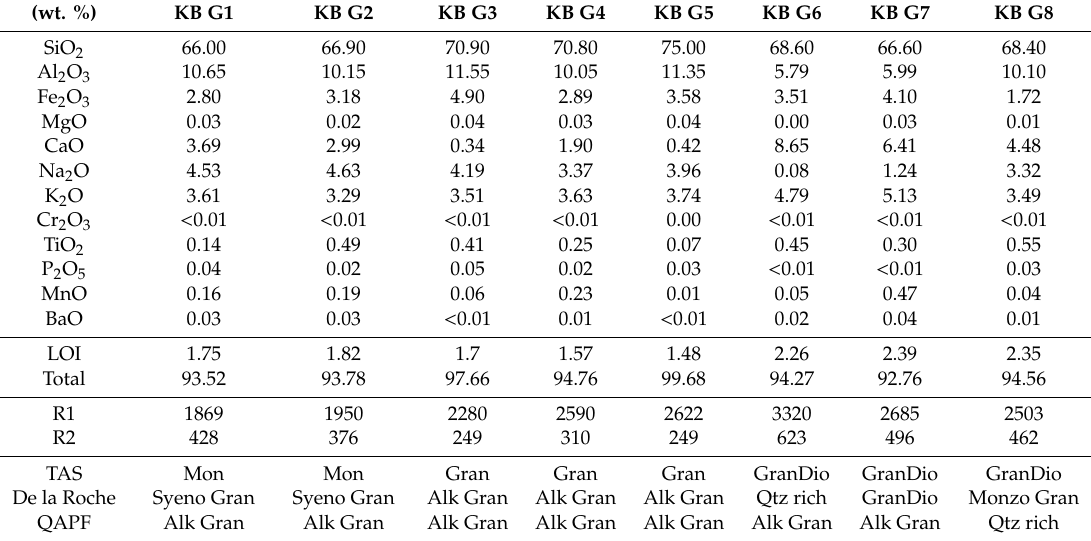
Table 1. Major element composition of KB G samples from western part metasomatites. TAS classification for plutonic rocks according to [22]. QAPF classification according to [20] on the basis of volumetric mineral composition as shown in Figure 2. Multication parameters R1 and R2 were calculated according to [21] with: R1 = 4Si − 11(Na + K) − 2(Fe + Ti), and R2 = 6Ca + 2Mg + Al. Abbreviations for abbreviations for de la Roche: Qtz rich = outside the classification fields, Alk Gran = alkali granite, Syeno Gran = syenogranite, Monzo Gran = monzogranite; LOI = loss on ignition. (wt. %) KB